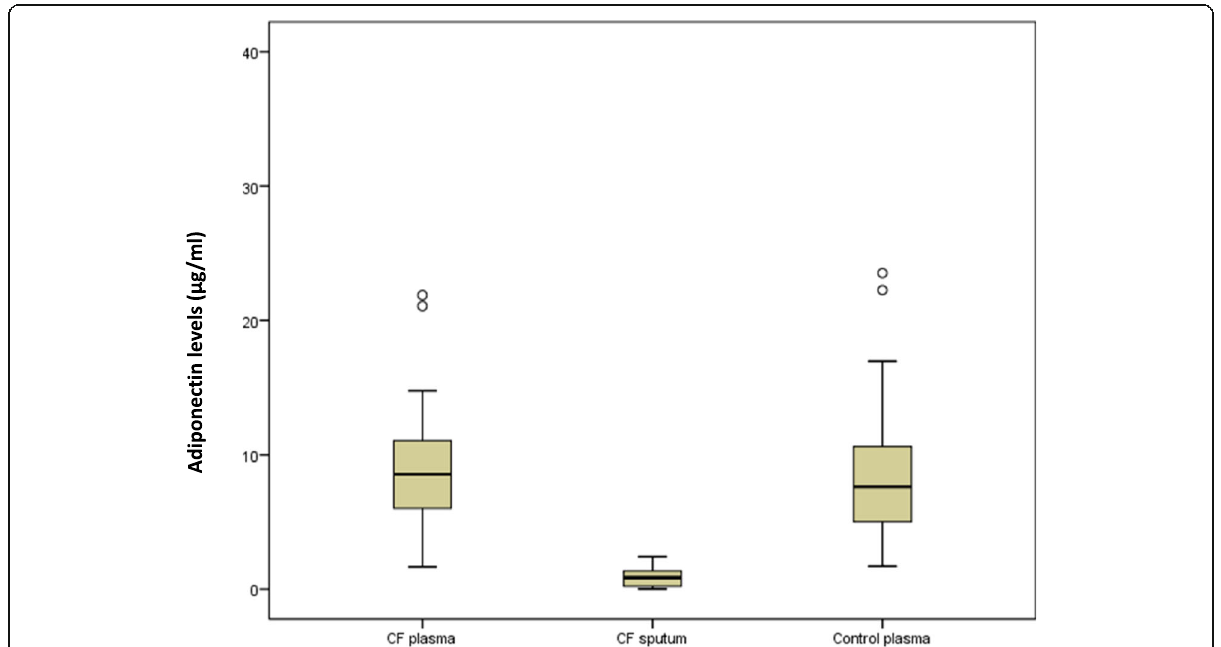
Fig. 1 Distribution of adiponectin levels in 3 groups (serum adiponectin in CF, serum adiponectin in healthy control and sputum adiponectin in CF